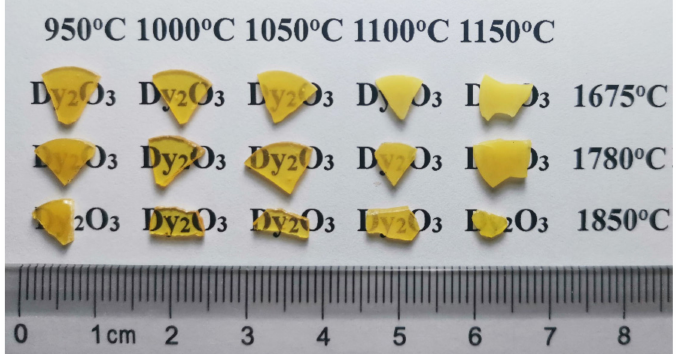
Figure 7. Photograph of the Dy 2 O 3 ceramics vacuum sintered at 1675, 1780, and 1850 ◦ C for 10 h and